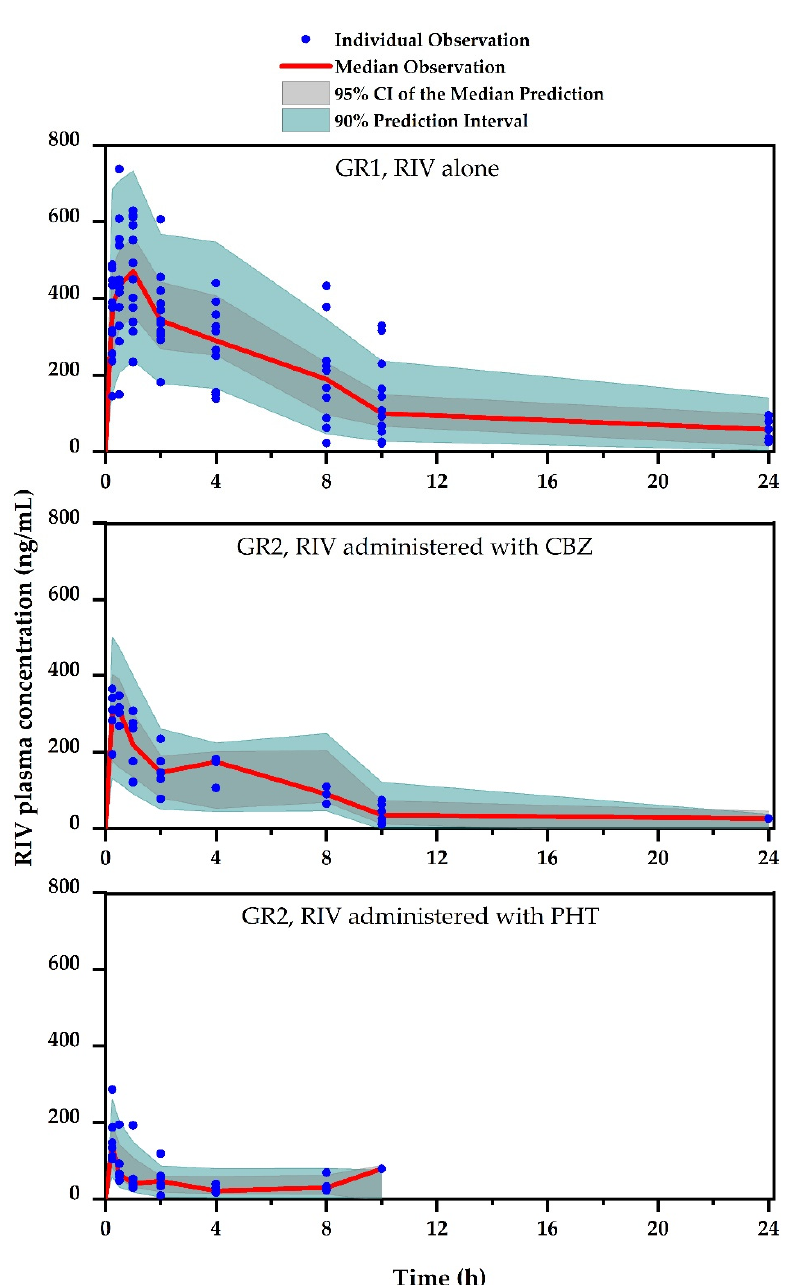
Figure 5. Visual predictive check for the final model on population PKs of RIV.